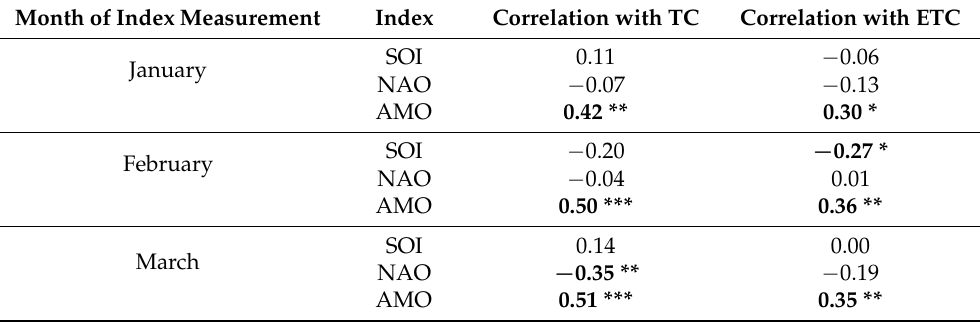
Table 2. Correlation coefficients between monthly SOI and NAO indices and TC or ETC abundance in September–October. In bold, statistically significant results at the significance level of α < 0.05 (one asterisk), α < 0.01 (two asterisks), α < 0.001 (three asterisks) are